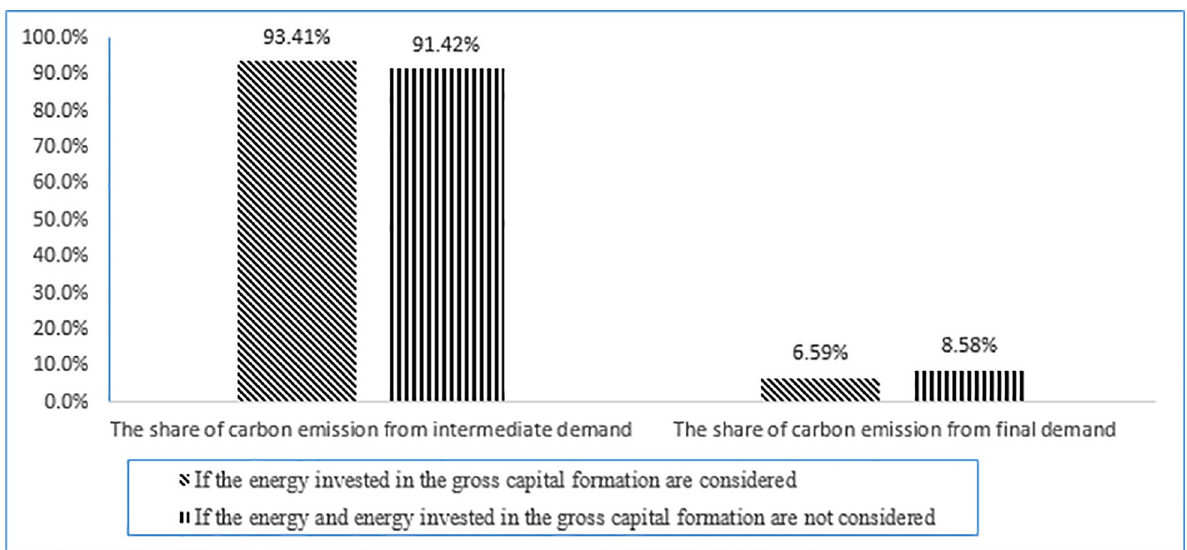
Fig 1. Calculation error of energy carbon emission when energy invest in gross capital formation and export are ignored.